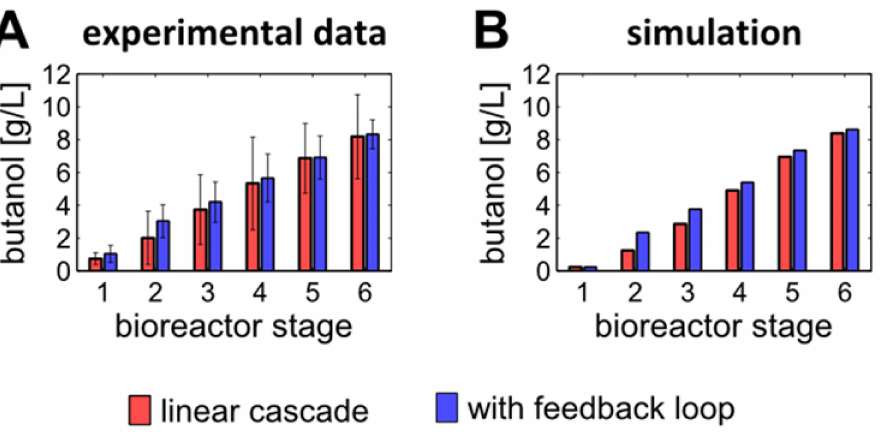
Figure 6. Butanol concentrations with and without feedback loop. Experiments and simulations were performed at D br1 = 0.55 h − 1 /pH br1 = 4.3 and F back = 0.055 L h − 1 (corresponding to 0.25 Fin) ( A ) experimental data; ( B ) simulation.